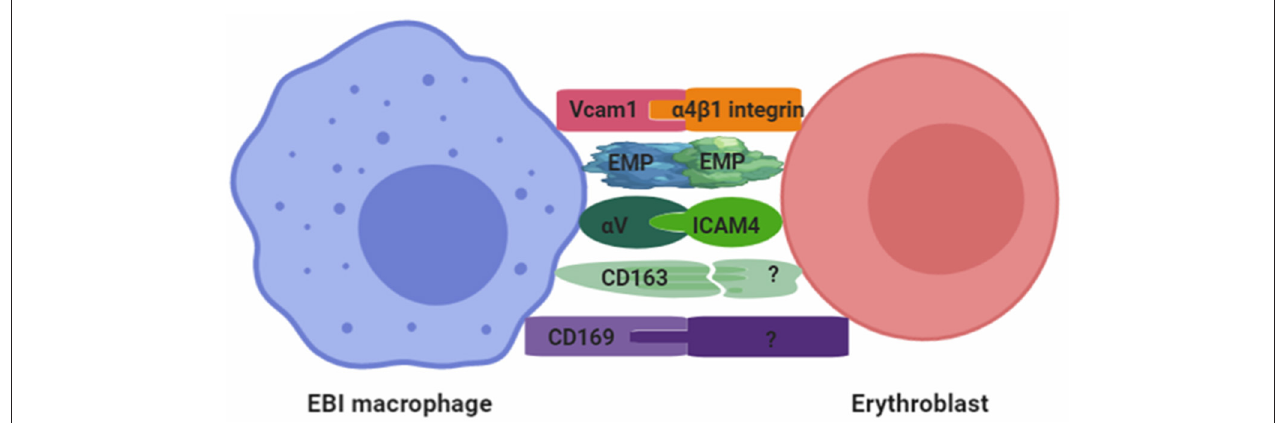
FIGURE 2 | Adhesion molecules involved in the formation of